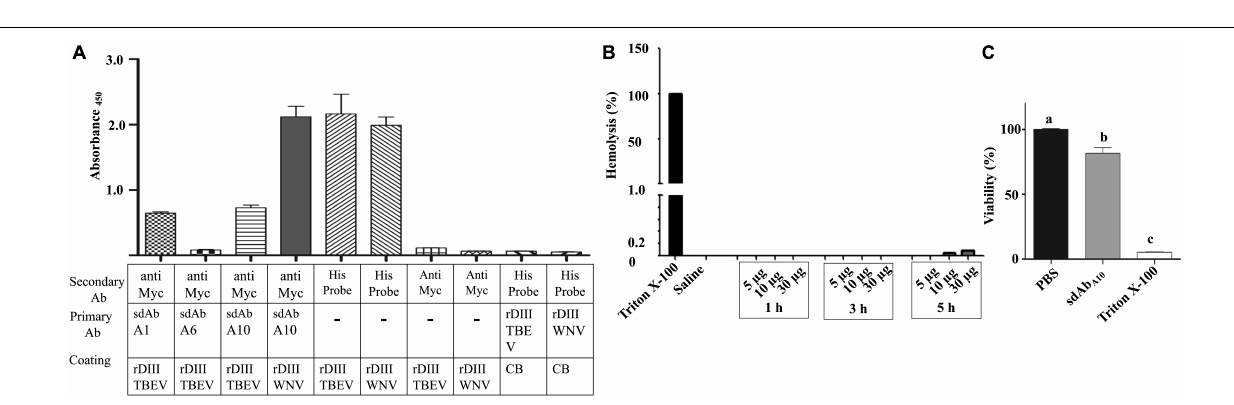
FIGURE 6 | Cross-reactivity, hemocompatibility, and safety of sdAb s . (A) the interaction between sdAbs and rDIII of TBEV was assessed on ELISA to determine possible cross-reactivity. Antigen-coated (Coating), primary (primary Ab), and secondary (secondary Ab) antibodies used in the ELISA are mentioned under each bar graph of Absorbance 450 values (Mean + SE). CB, coating buffer; Anti Myc, antiMyc antibody; HisProbe, HisProbe HRP conjugate. (B) Percentage of hemolysis in sheep erythrocytes caused by 5–30 µ g of sdAb A10 was determined by measuring the absorbance of oxyhemoglobin at 414 nm over a period of 1–5 h. Even at the highest concentration of sdAb A10 , just 0.1% hemolysis was observed as compared to 0 and 100% of hemolysis in 0.9% saline (negative control) and 2% Triton X (positive control) treated erythrocytes, respectively. The entire assay was performed in triplicate, and the bar graphs represent mean ± SE. (C) XTT based proliferation assay on hBMECs treated with either 2 µ g (143 pM) of sdAb A10 , 1 × PBS (negative control), and 0.1% Triton X-100 (positive control) was performed in triplicate. hBMECs treated with sdAb A10 showed 82% viability as compared with 100% viability in negative control and 5% viability in positive control groups. The data represent mean + SE absorbance values measured at 450 nm on an ELISA plate reader. The significant difference between the compared treatments by one-way ANOVA ( p < 0.05) is indicated by different